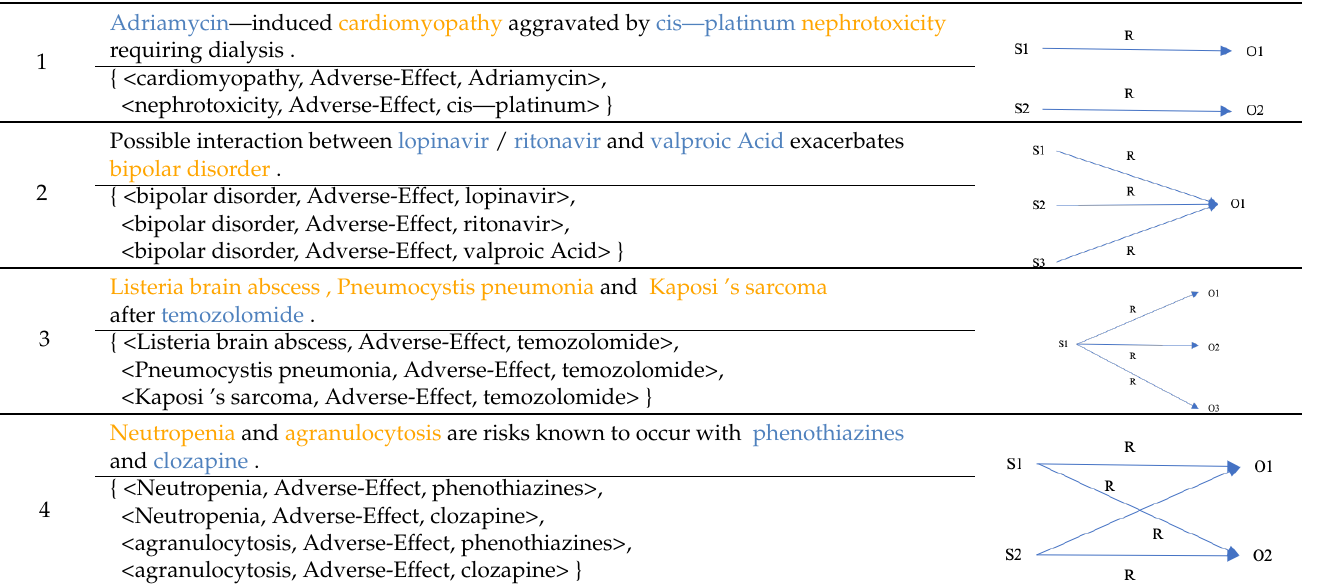
Table 1. Triples in the ADE dataset, including multiple triples (1), subjects and (cid:104) R , O (cid:105) many-to-one (2), (cid:104) S , R (cid:105) and objects one-to-many (3), and subjects and objects crossing (4). The subjects are marked in orange, and the objects are marked in blue.